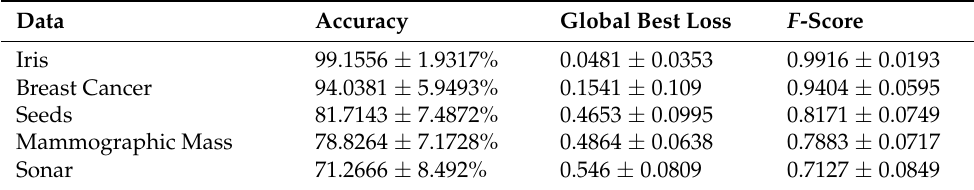
Table 5. Results from the FNN-PSO Algorithm.